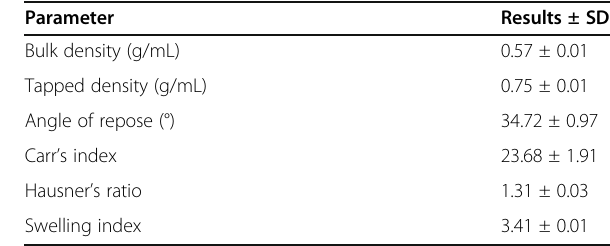
Table 3 Micromeritics and rheological properties of Khaya